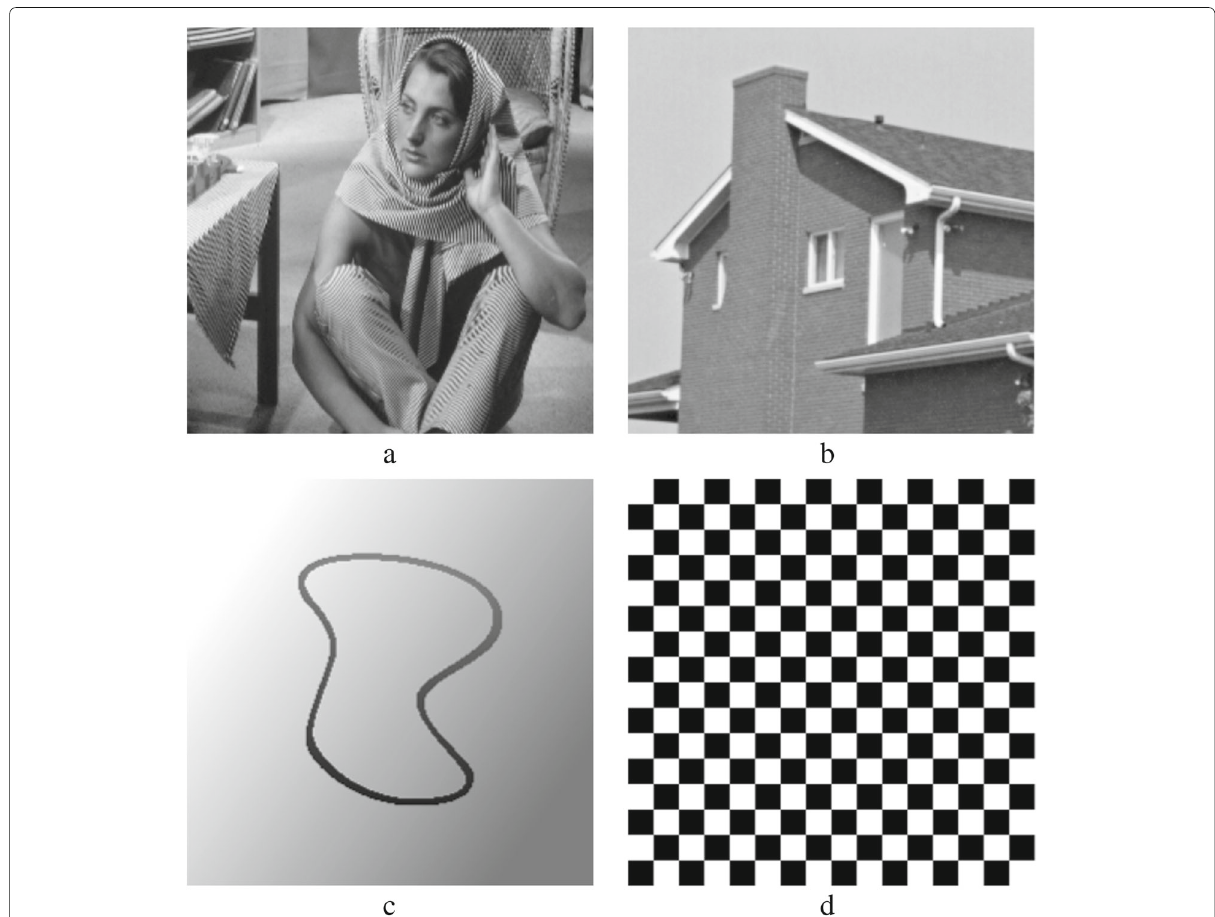
Fig. 10 The four used images in the experiment: a Barbara image 512 × 512, b House image 256 × 256, c CurvedBand image 257 × 257, and d Chessboard image 256 ×